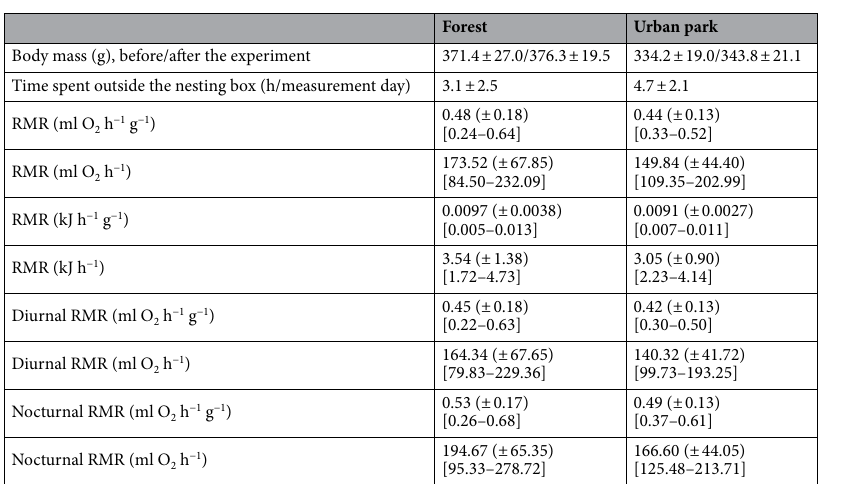
Table 1. Mean values (± SD) for body mass (before/after the housing period) and time spent outside the nesting box as well as mean values (± SD) and ranges (in square brackets) for mass-dependent and total RMR of forest (N forest = 7, n forest = 22) versus urban squirrels (N urban = 13, n urban = 35). Given are daily RMR averages (in ml O 2 and in kJ), as well as diurnal and nocturnal